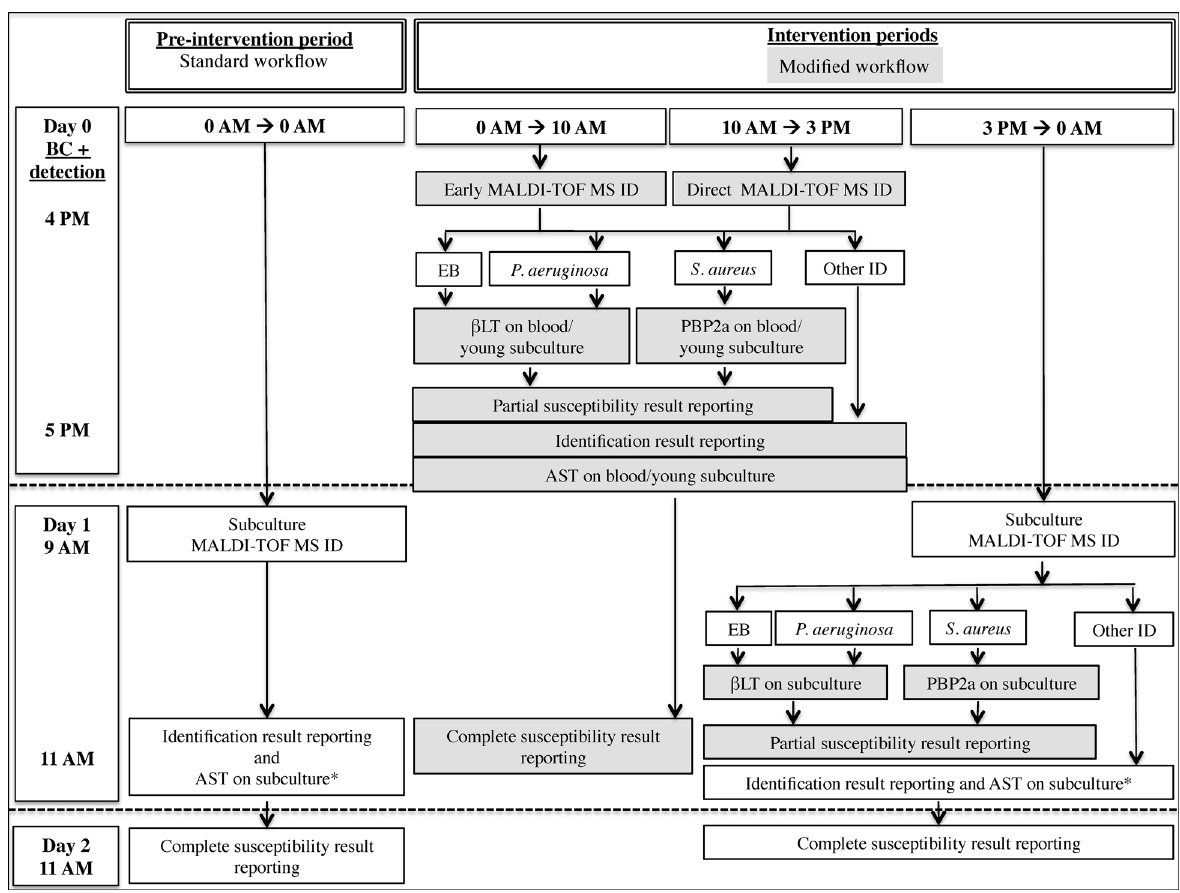
Fig 1. Laboratory workflow of positive blood culture bottles according to time of positivity detection during pre-intervention and intervention periods. AST, antimicrobial susceptibility testing; BC, blood culture; β LT, β LACTA test; EB, Enterobacteriaceae; ID, identification; MALDI-TOF MS, matrix-assisted laser desorption ionization time-of-flight mass spectrometry; PBP2a, PBP2a Culture Colony Test. * : AST was directly performed from positive blood culture fluid when Gram staining identified a Gram-negative rod. Grey squares highlight the accelerated identification and susceptibility tests applied in the modified